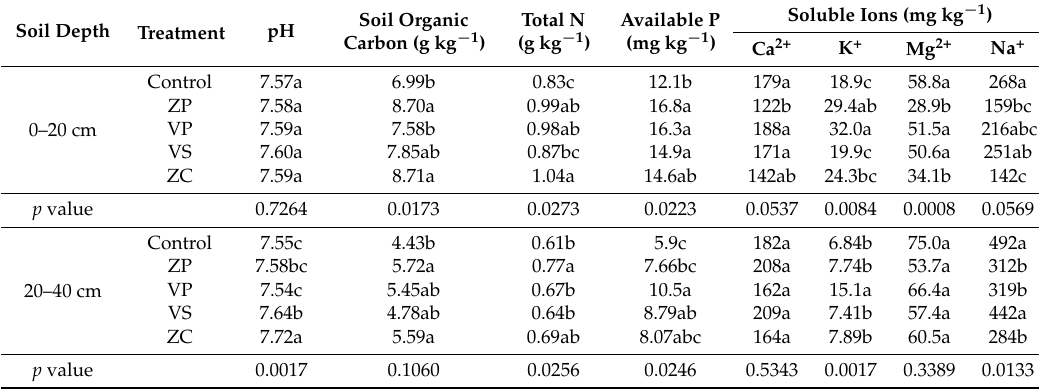
Values represent the mean of three replicates. Different letters (a, b, and c) denote significant difference ( p < 0.05) within a column as determined by Duncan’s multiple comparison test.